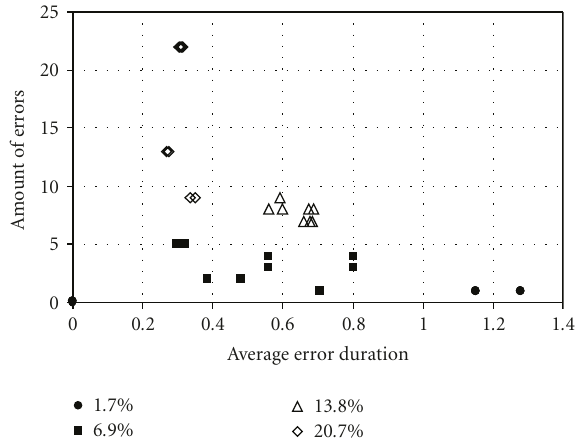
Figure 8: Audio errors for MFER 1.7%, 6.9%, 13.8%, and 20.7% for the test performed in